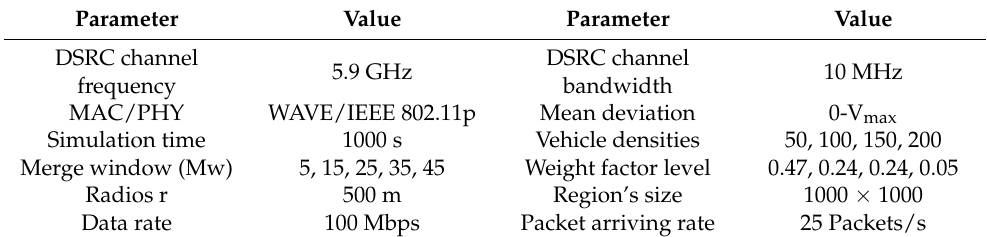
Table 1. Simulation